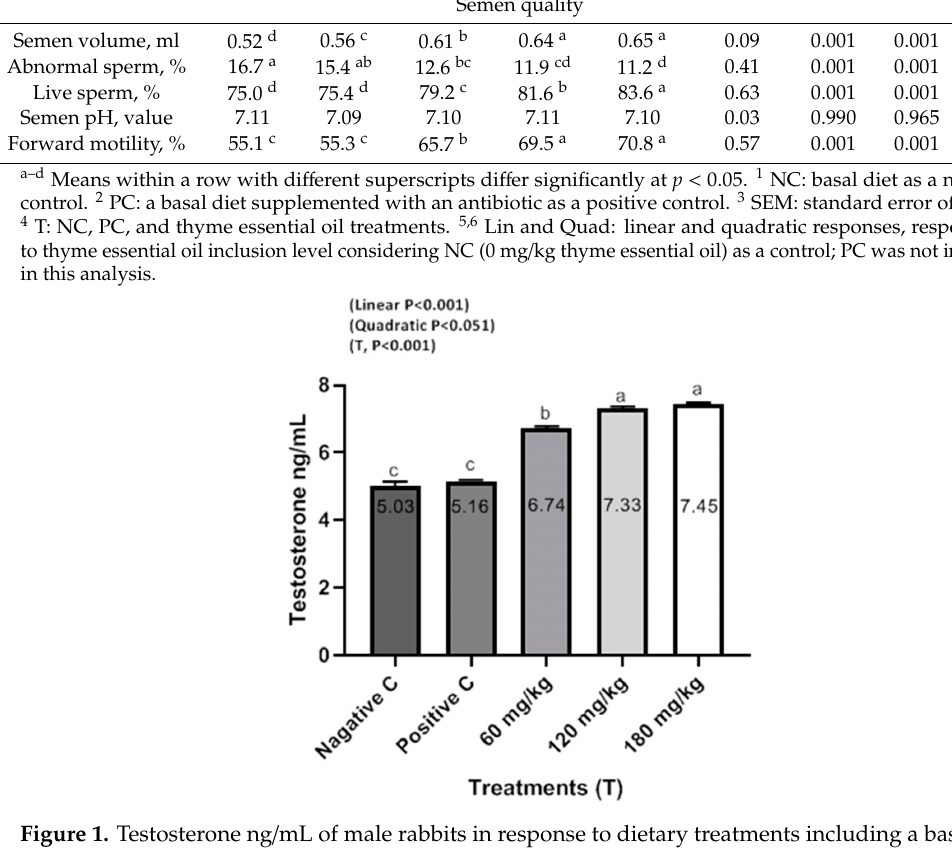
Figure 3. Serum creatinine mg/dl and urea mg/dl of male rabbits in response to dietary treatments including a basal diet (NC), a basal diet supplemented with a 500 mg/kg oxytetracycline antibiotic (PC), and a basal diet supplemented with 60, 120, or 180 mg/kg of TEO at 130 days of age. a–d Means within a row with different superscripts differ significantly at P < 0.05. 4. Discussion It is extremely difficult to compare the studies that applied different essential oils because the results will be based on numerous factors, including essential composition, doses, extract methods and application, animal age, and housing conditions. The TEO feed additive, as an alternative to dietary antibiotics, is highly safe and could be utilized for improving the productive and reproductive performance of rabbits. The effects the phytogenic substances have on the intestinal health, antioxidant status, and antimicrobial activity are considered essential for the biological activities; however, studies lack the determination of active components, and their mechanisms are still not